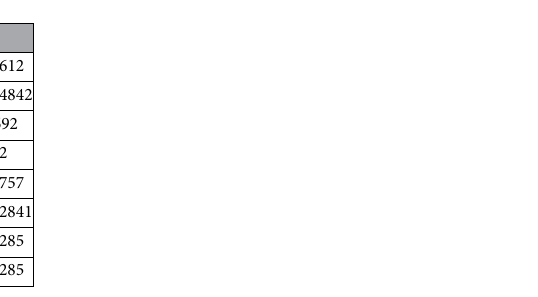
Figure 7. Structure of the pectin (tetramer) taken in 2D and 3D.